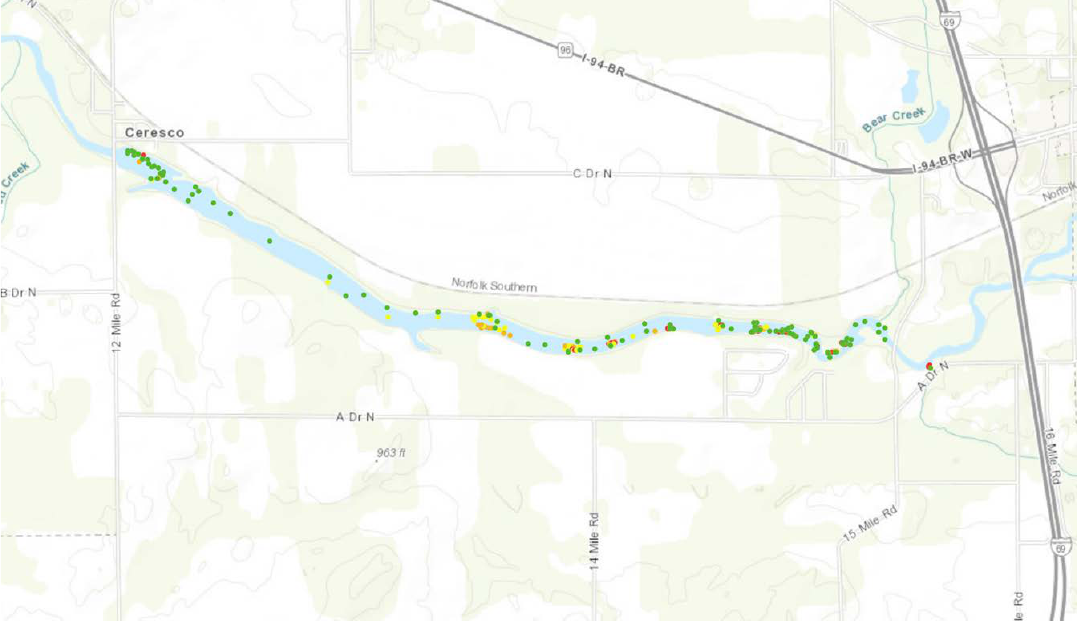
Figure 6. Poling data from 29 August–21 September 2010 input to SOSim. Created using ArcGIS Pro. The green dots correspond to no oiling, the yellow correspond to slight oiling, the orange to moderate oiling, and the red to heavy oiling.